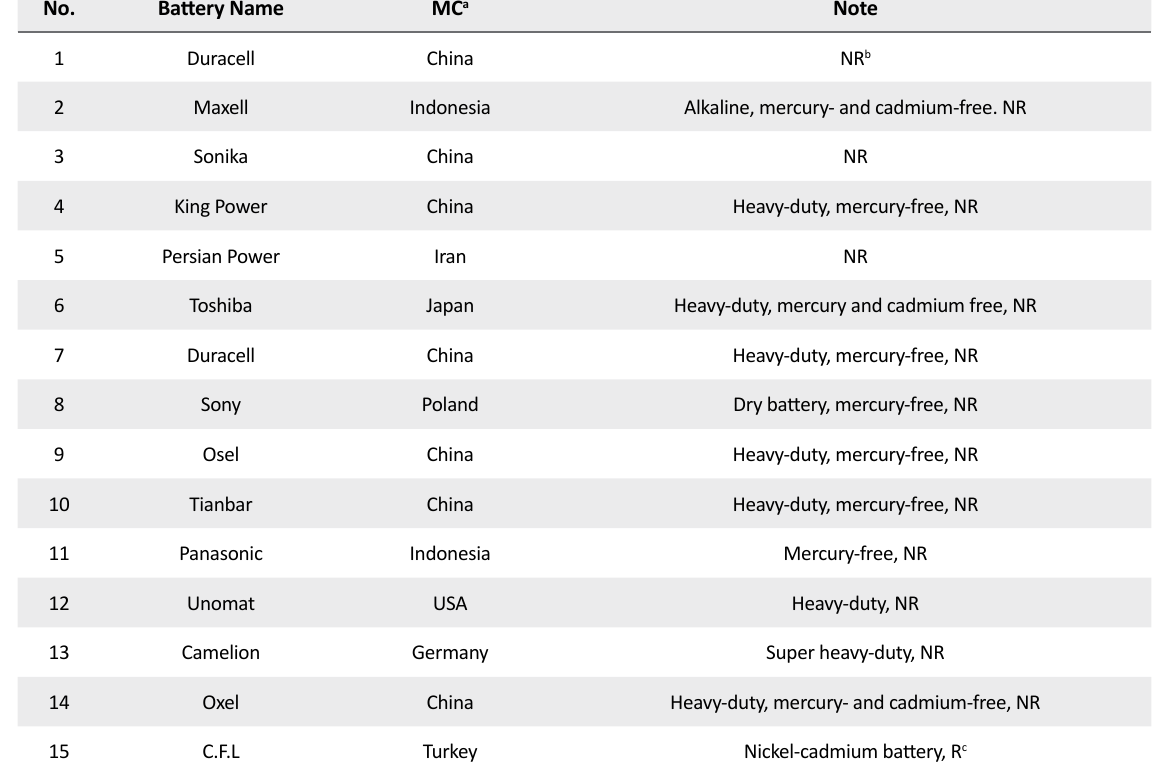
Table 1. Specifications of the studied used batteries